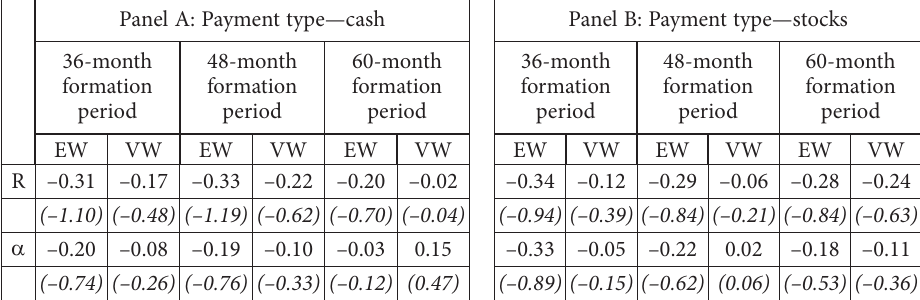
Table 2. Monthly returns on calendar-time portfolios of acquirers following deals paid for with cash and stocks Panel A: Payment type—cash Panel B: Payment